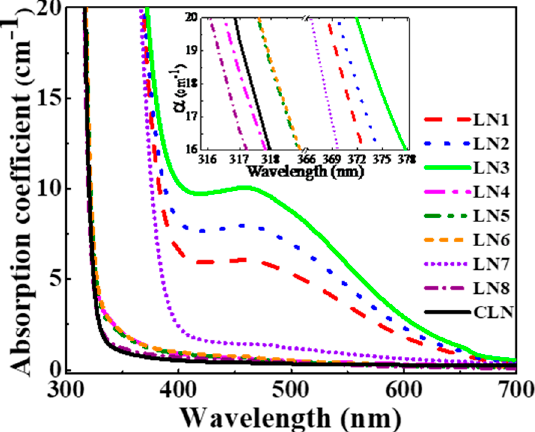
Figure 3. UV–Vis absorption spectra for all the prepared samples of LN1–LN8 and CLN; the inset shows the absorption edges for each crystal at 20 cm − 1 .